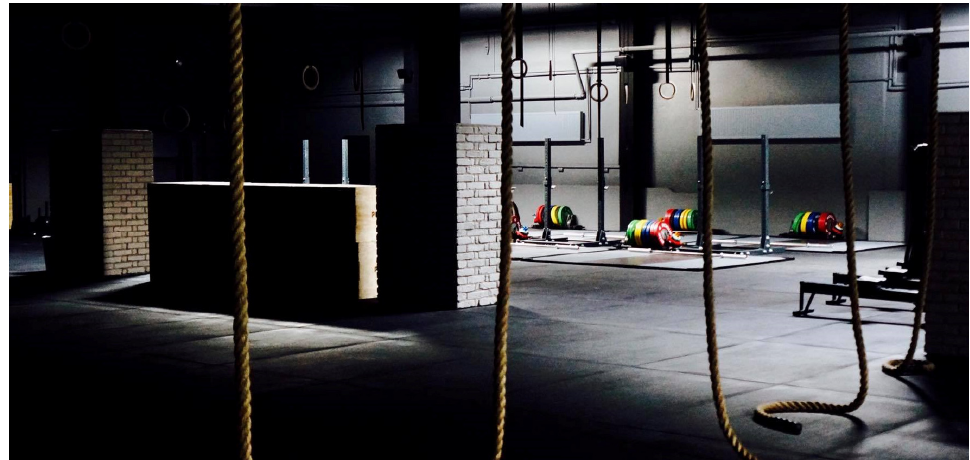
Figure 3. Industrial site adapted to a CrossFit box: weightlifting platforms and plyometric boxes.